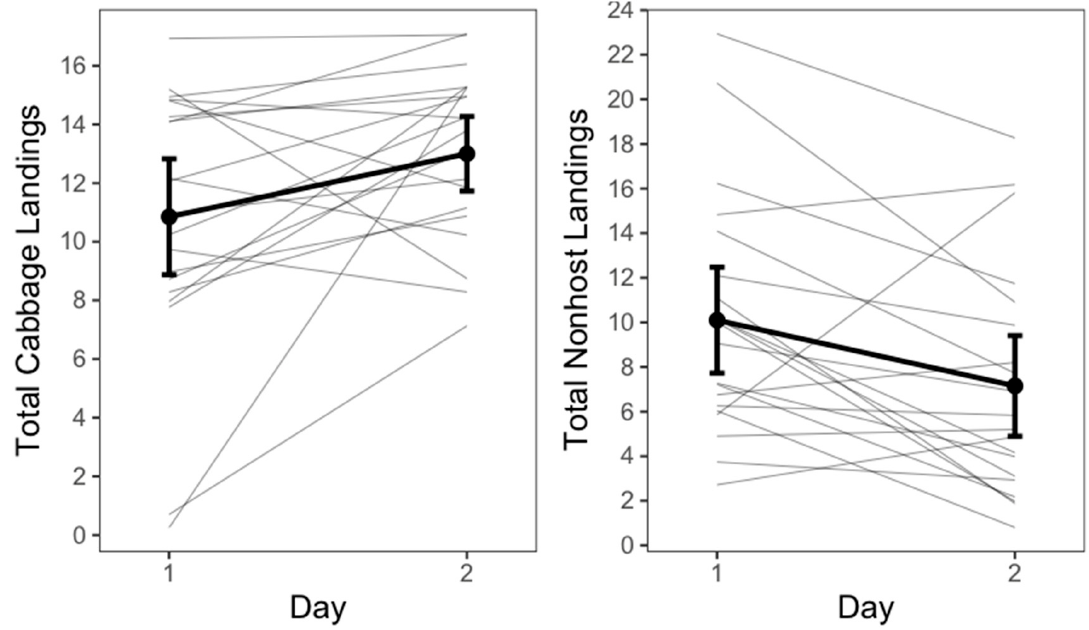
Figure 3. Butterfly host landings and host ‐ finding accuracy over the course of two days. Butterflies increased their visits on cabbage from Day 1 to Day 2 ( left ). Butterflies decreased their landings on non ‐ hosts from Day 1 to Day 2 ( right ). Points and bars represent means and + 1.96 SE. Light gray lines connect data from individual butterflies and are slightly jittered for easier visualization.